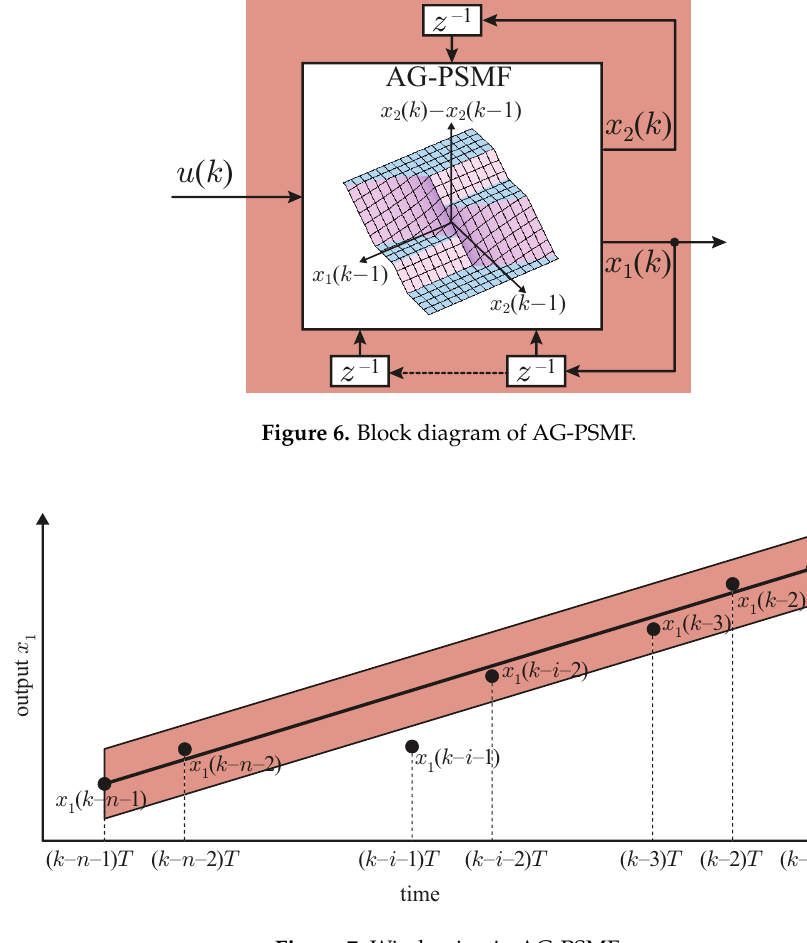
Figure 7. Windowing in